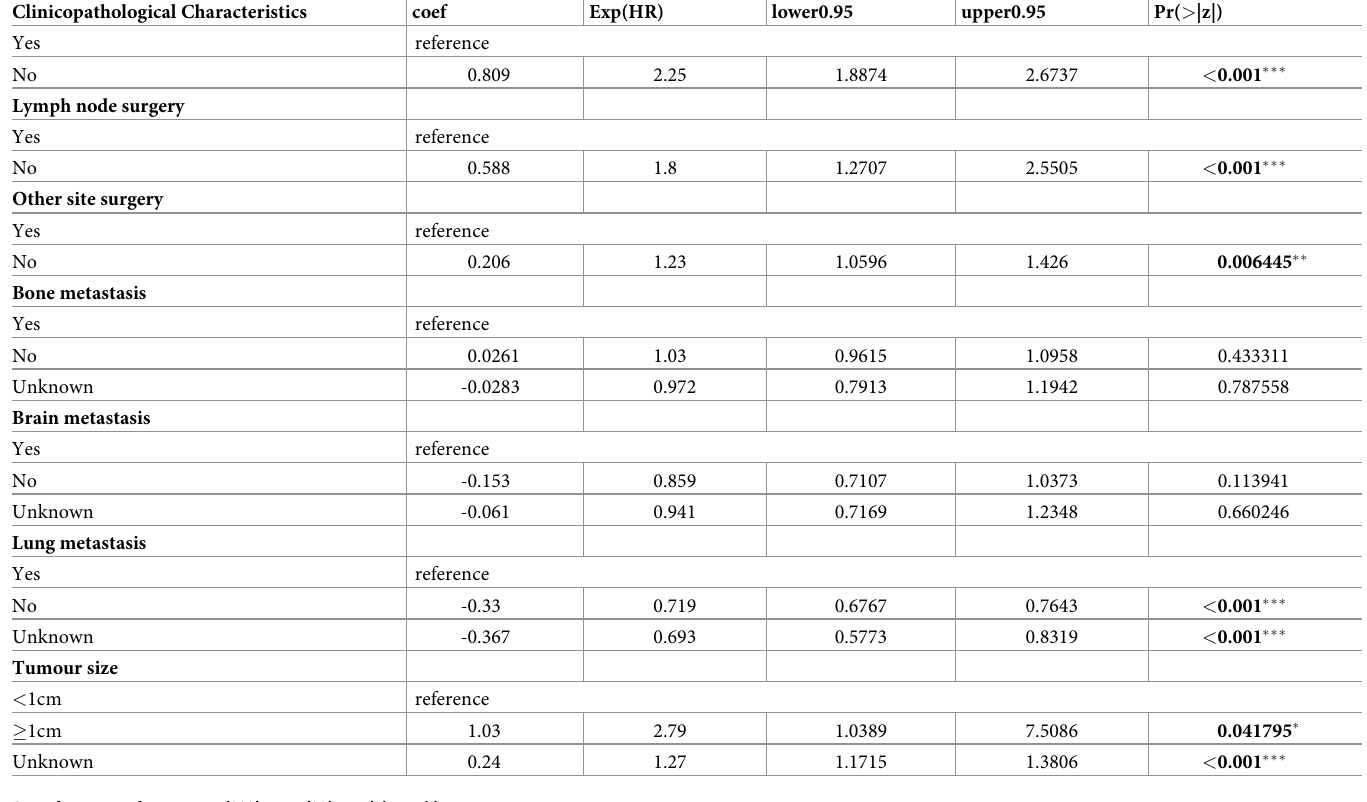
different histological types, patients diagnosed with spindle cell type had the worst prognosis (HR = 1.760, 95%CI: 1.103–2.814, p < 0.050) while fibrolamellar had the best prognosis (HR = 0.539, 95%CI: 0.353–0.824, p < 0.050). Also, Kaplan-Meier curve confirmed these results (Fig 3C). However, among the 5274 samples, about 98% samples were NOS types, and other types were less. Effective statistical analysis cannot be performed due to the large difference in sample size. Therefore, the results should be further confirmed. Moreover, no primary-sur- gery-treated patients showed the second highest HR related to survival (HR = 2.250, 95%CI, 1.887–2.673, p < 0.001), which may identify surgical treatment as the second most important factor affecting OS. Primary site surgery had a prominent effect on improving survival progno- sis (p < 0.050, Fig 3D). The most important factor affecting survival was tumour size � 1 (HR = 2.790, 95%CI, 1.039–7.509, p < 0.050). However, due to the insufficiency of cases, there is only 3 tumours with size � 1cm. Therefore, this result is controversial. It is noteworthy that patients diagnosed in 2015 exhibited a lower risk of death compared to other years, which might be explained by the insufficiency of the follow-up period. However, this outcome was not statistically significant (p =